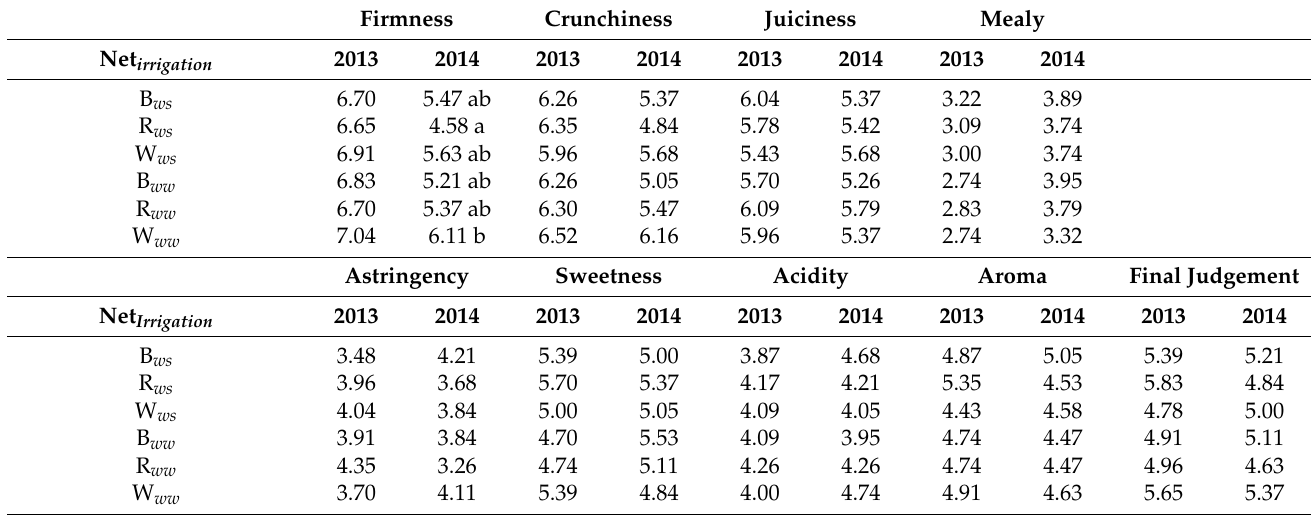
Table 9. Panel test mean scores of shading and irrigation effects on fruit sensory traits during the years 2013 and 2014. Different letters indicate significant differences at p < 0.05. No letters indicate no significant differences. In the lower part of the table, F values of linear contrast for each year are shown; values below 0.05 are considered significant.